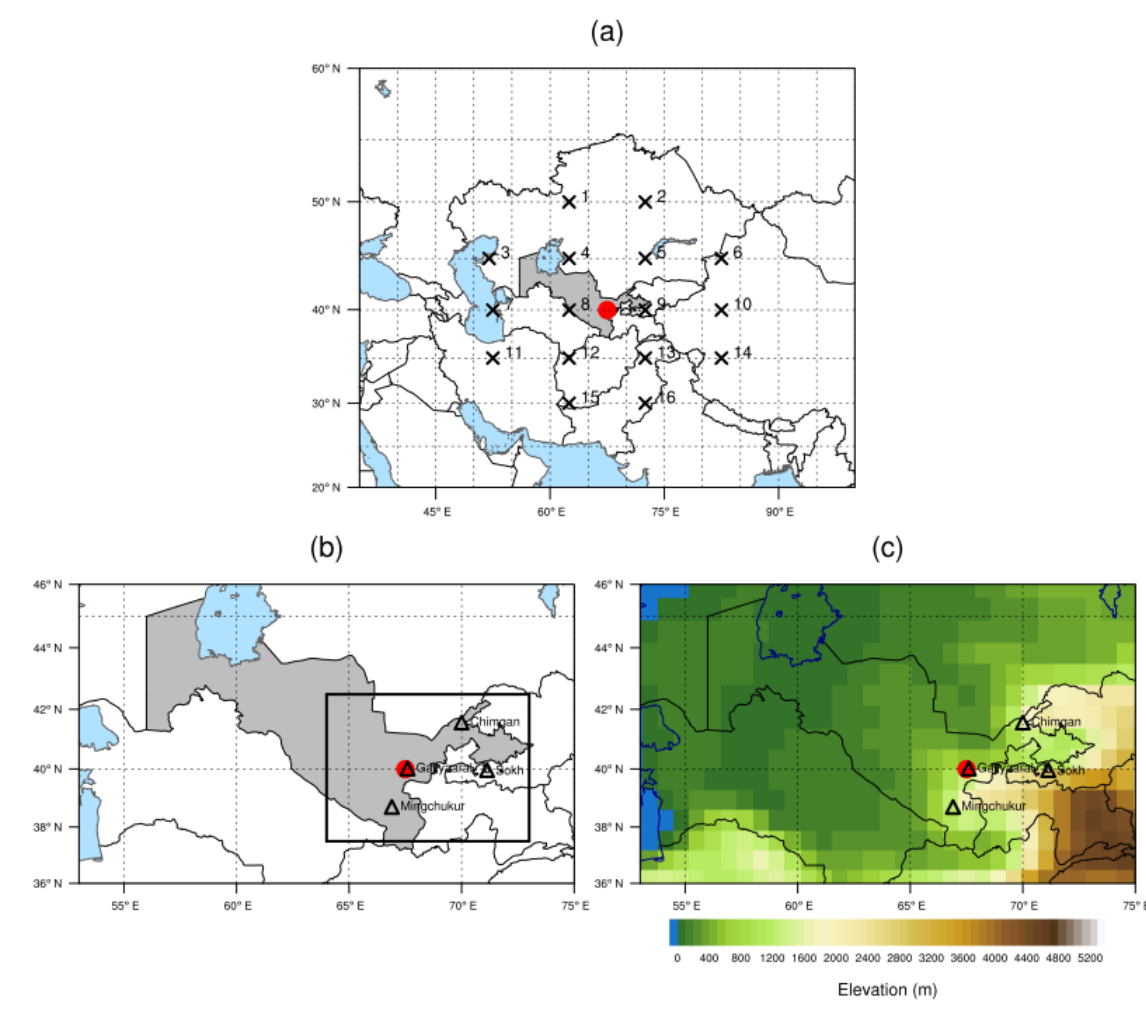
Figure 9. (a) Location of the study domain together with the 16 grid points and central grid point (40 ◦ N–67.5 ◦ E, red circle) used in the automated weather circulation type. (b) Investigation area shown in the rectangle and location of selected stations (black triangles) around the central grid point 40.0 ◦ N–67.5 ◦ E (red circle) of the CWT objective method. Stations include Gallyaaral (40.02 ◦ N–67.60 ◦ E), Chimgan (41.57 ◦ N–70.00 ◦ E), So’x (39.97 ◦ N–71.13 ◦ E) and Mingchukur (38.70 ◦ N–66.90 ◦ E). (c) ERA-Interim orography map and the location of the central grid point (red circle) together with the representative four stations (black